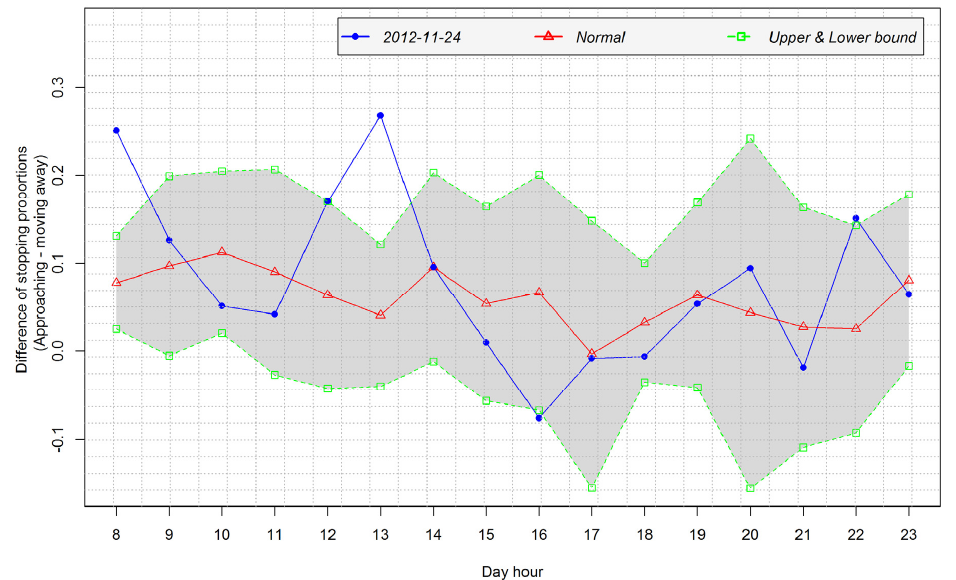
Figure 9. Temporal variation of the difference of stoppings proportions between approaching and moving-away (V ), its normal value ( W ), and its upper and lower bounds ( UV , LV ) on a day with an event.